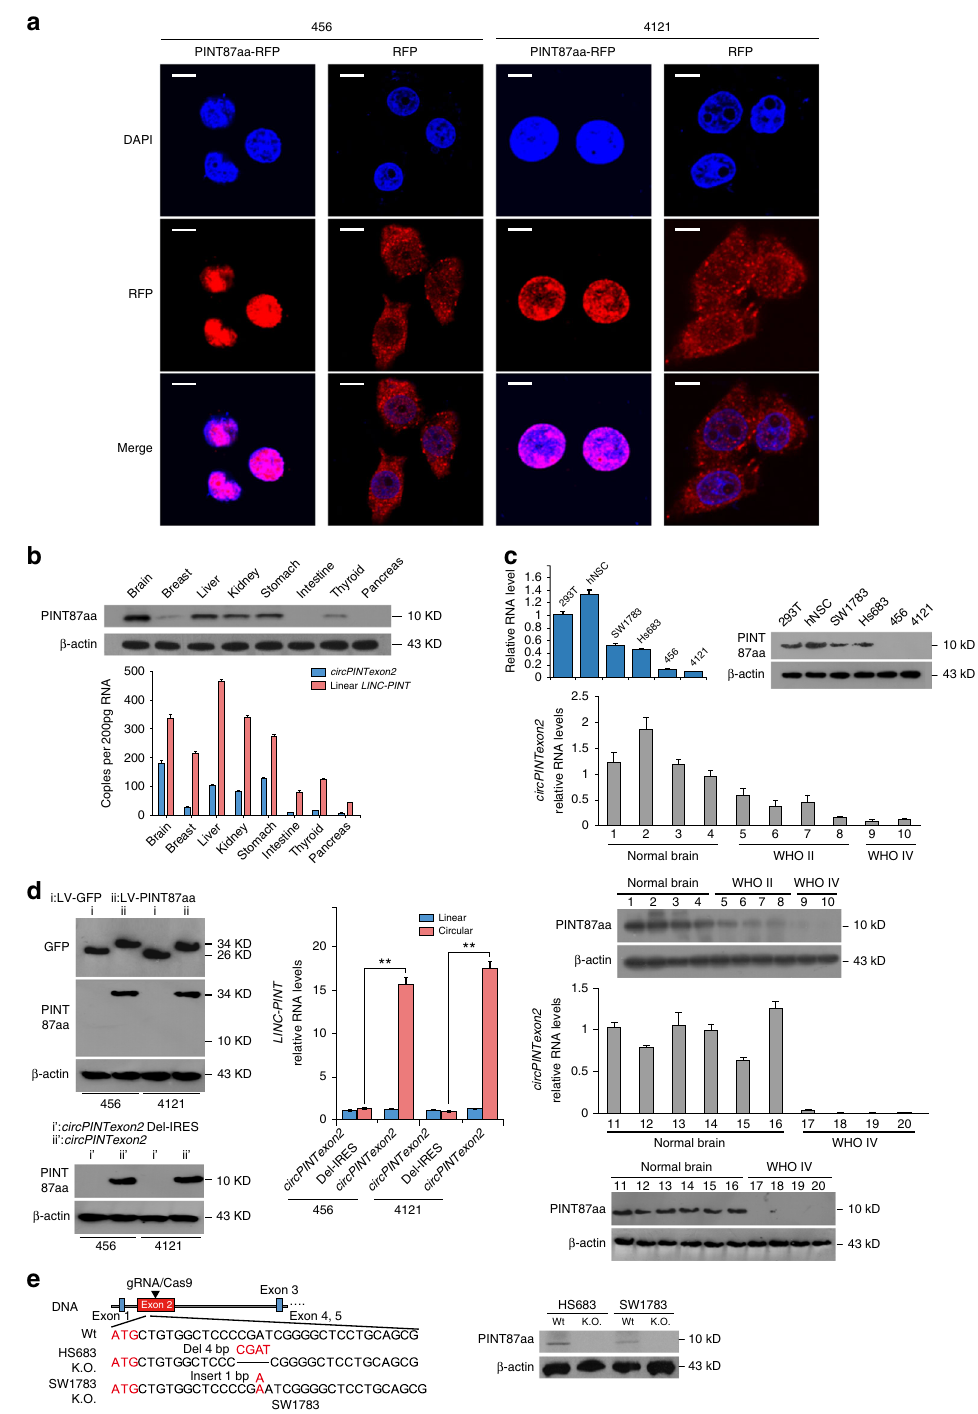
Fig. 4 Localization and expression of PINT87aa in cells and human tissues. a IF microscopy images of the cellular localization of the PINT87aa-RFP-fusion protein in 456 and 4121 BTIC cells showing stable overexpression. Scale bars, 20 μ M. b The expression of circPINTexon2 and PINT87aa was detected in human brain, breast, liver, kidney, stomach, intestine, thyroid, and pancreas tissues. c Upper panel, the expression of circPINTexon2 and PINT87aa was detected in hNSC, 293T, Hs683, SW1783, 4121, 456, 387, and H2S cells. Lower panel, circPINTexon2 and PINT87aa levels were determined in normal brain and gliomas with different WHO grades. d Establishment of linear vector-transduced stable PINT87aa-GFP 456 and 4121 cells and arti fi cial circPINTexon2 - transduced stable PINT87aa 456 and 4121 cells. Data are presented as mean ± s.e.m. from three independent experiments. ** P < 0.01; ns, P > 0.05, determined by two-tailed Student ’ s t -tests. e Establishment of PINT87aa K.O. SW1783 and Hs683 cells using CRISPR/Cas9 technology. Schematic illustration showing that the genomic regions of the LINC-PINT exon2 contained the 87-aa ORF. gRNAs designed to target the PINT87aa ORF are shown. Genomic K.O. effects were con fi rmed via Sanger sequencing, as shown in Supplementary Fig. 7. Western blotting revealed the effects of PINT87aa K.O. in SW1783 and Hs683